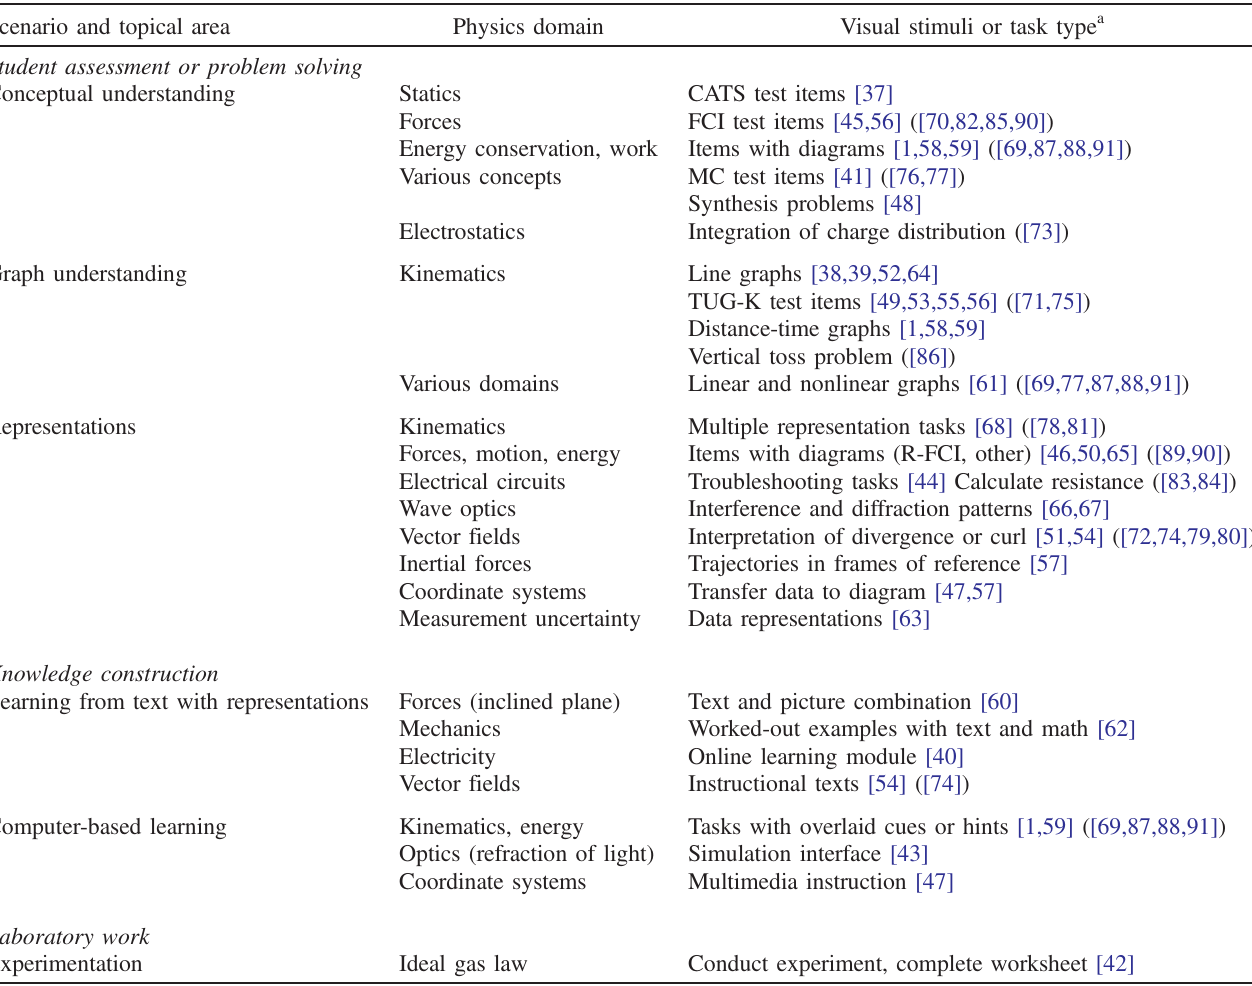
TABLE II. Dissemination and use scenarios of eye tracking. References to nonjournal articles are included in parentheses. Note that studies that appear in both the assessment and knowledge construction category used eye tracking in both scenarios. Scenario and topical